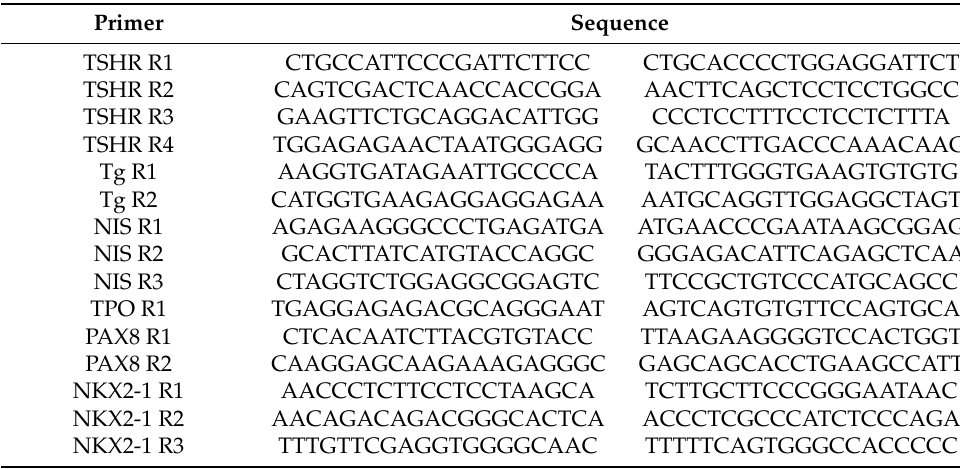
Table 4. Primer information for